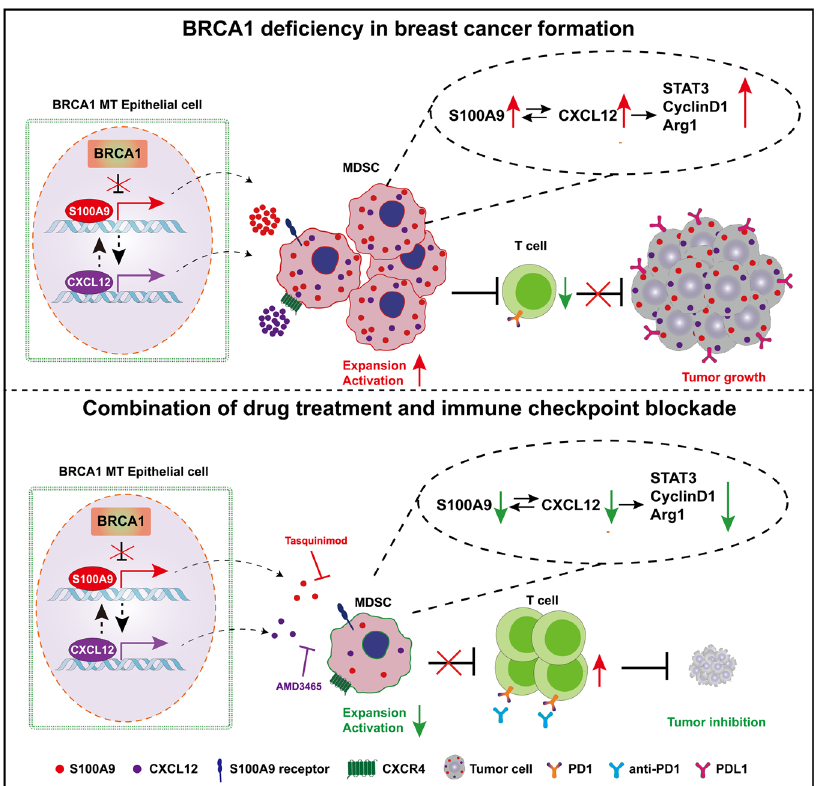
Fig. 8 Schematic for the mechanisms by which BRCA1 de fi ciency in breast cancer formation and improves responses to anti – PD1 antibody. In BRCA1 de fi ciency epithelial cells, S100A9 expression level constantly increases in early stages and secrets out to recruit and activate MDSCs, which creates an immunosuppression microenvironment by inhibit expansion and activation of T cells. This process can be further enhanced by CXCL12 that positively regulated by S100A9 and form a positive feedback loop. And this immunosuppression microenvironment is bene fi cial for tumor growth. The inhibitors of S100A9 and CXCL12, Tasquinimod and AMD3465, combine with anti-PD1 antibody can rescue the immunosuppression microenvironment and repress tumor growth. Green arrows indicate a decrease; red arrows indicate an